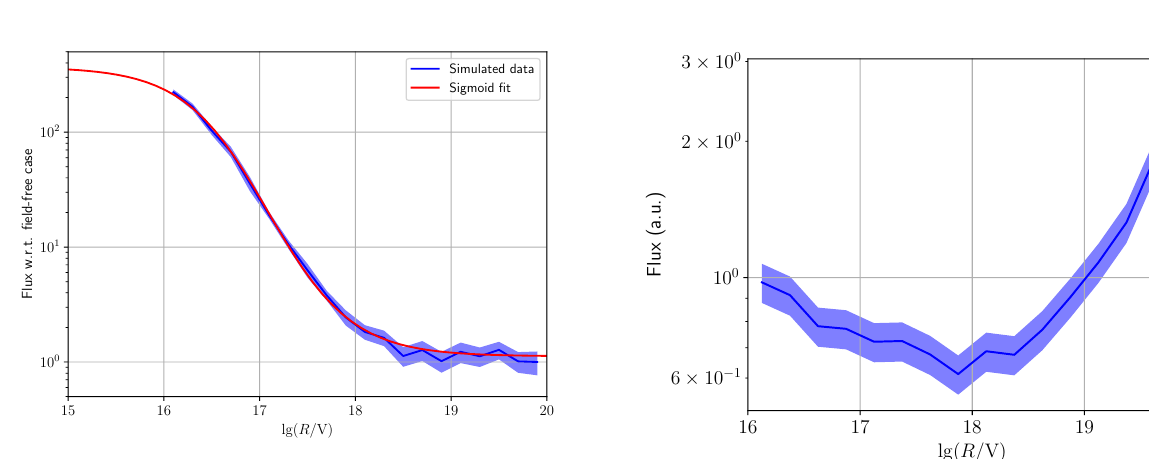
originating from Centaurus A imposed by the GMF (from